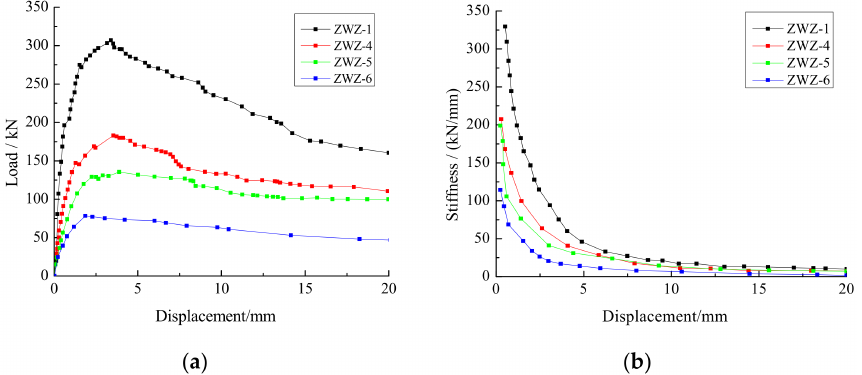
Figure 23. Load–displacement and stiffness–displacement curves of the walls with different window holes’ dimensions: ( a ) load–displacement curves; ( b ) stiffness–displacement